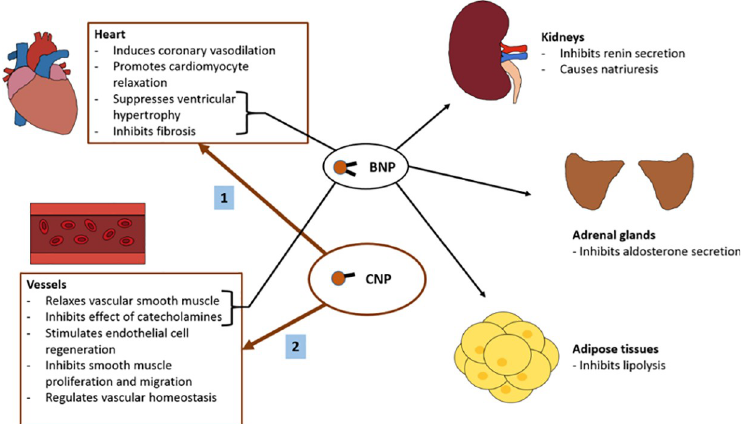
Fig 1. Function of C-type natriuretic peptide. CNP is an endothelium-derived peptide that is believed to have a cardioprotective function in both healthy and disease states. While BNP directly causes natriuresis in addition to other functions, CNP acts primarily on the heart and blood vessels. In the heart, CNP induces coronary vasodilation, promotes cardiomyocyte relaxation, and exerts antihypertrophic and antifibrotic effects. In the vessels, CNP relaxes smooth muscle and inhibits its proliferation and migration, while also inhibiting catecholaminergic effects, stimulating endothelial cell regeneration, and regulating vascular homeostasis. (BNP–B-type natriuretic peptide, CNP–C-type natriuretic